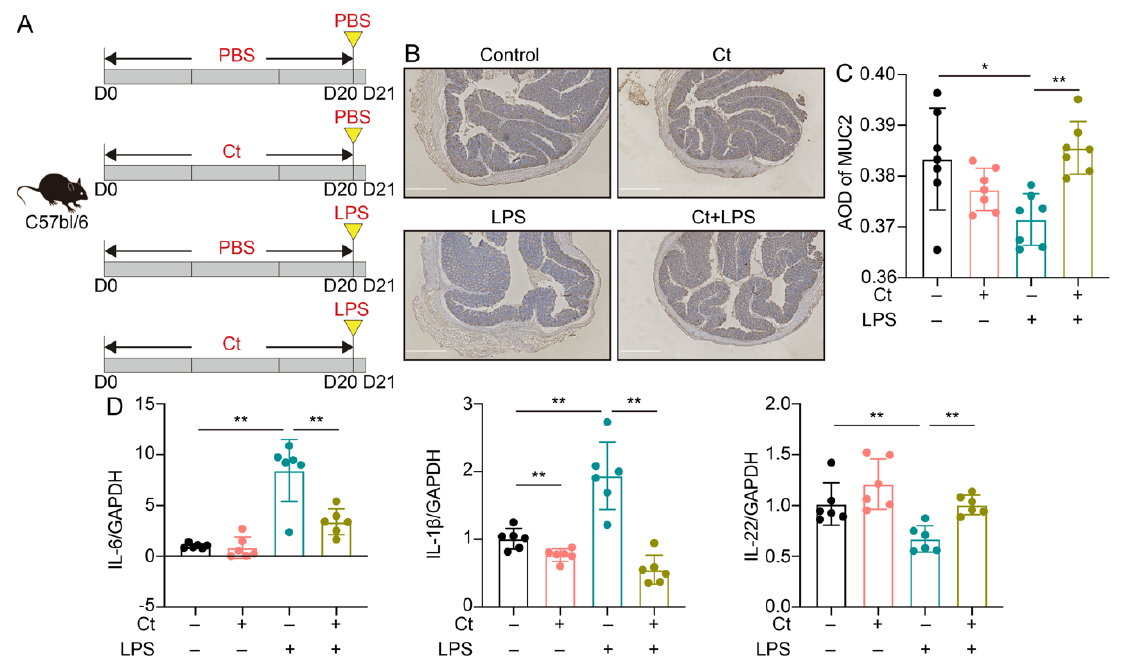
Figure 1. C. tyrobutyricum ATCC25755 (Ct) efficiently attenuated colonic inflammation in mice. ( A ) Schematic for the feeding experiment. C57BL/6 mice were treated with phosphate buffer saline (PBS) or 10 8 CFU/mL Ct by gavage every day for 20 days followed by intraperitoneal injection with PBS or lipopolysaccharide (LPS) (10 mg/kg, Body Wight, BW) at day 20 (D20), the samples were collected after 24 h (Control, n = 10; Ct, n = 10; LPS, n = 12; Ct + LPS, n = 12); ( B ) immunohistochemistry images of colonic MUC2. Scale bars: 250 µ m; ( C ) average optical density (AOD) of MUC2; ( D ) relative mRNA expression of IL-6, IL-1 β , and IL-22 in the colon ( n = 6). Data presented as mean ± SEM. * p < 0.05, ** p < 0.01 by two-way unpaired t